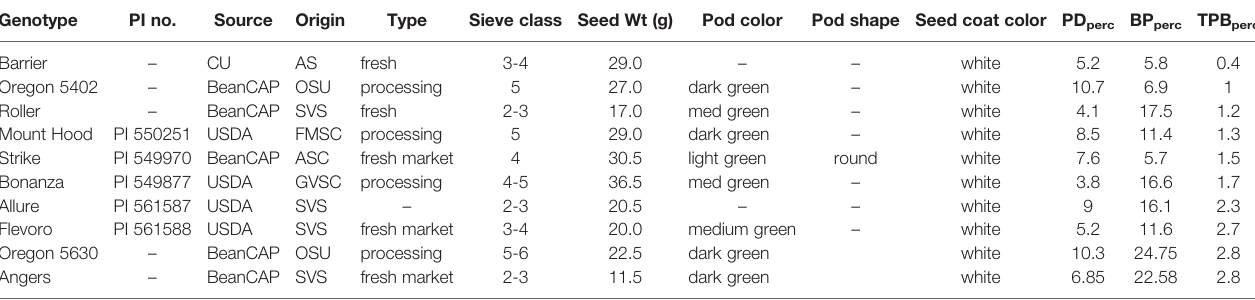
TABLE 3 | List of snap bean genotypes in the SNAP diversity panel most sensitive to sulfentrazone. Genotype PI no.